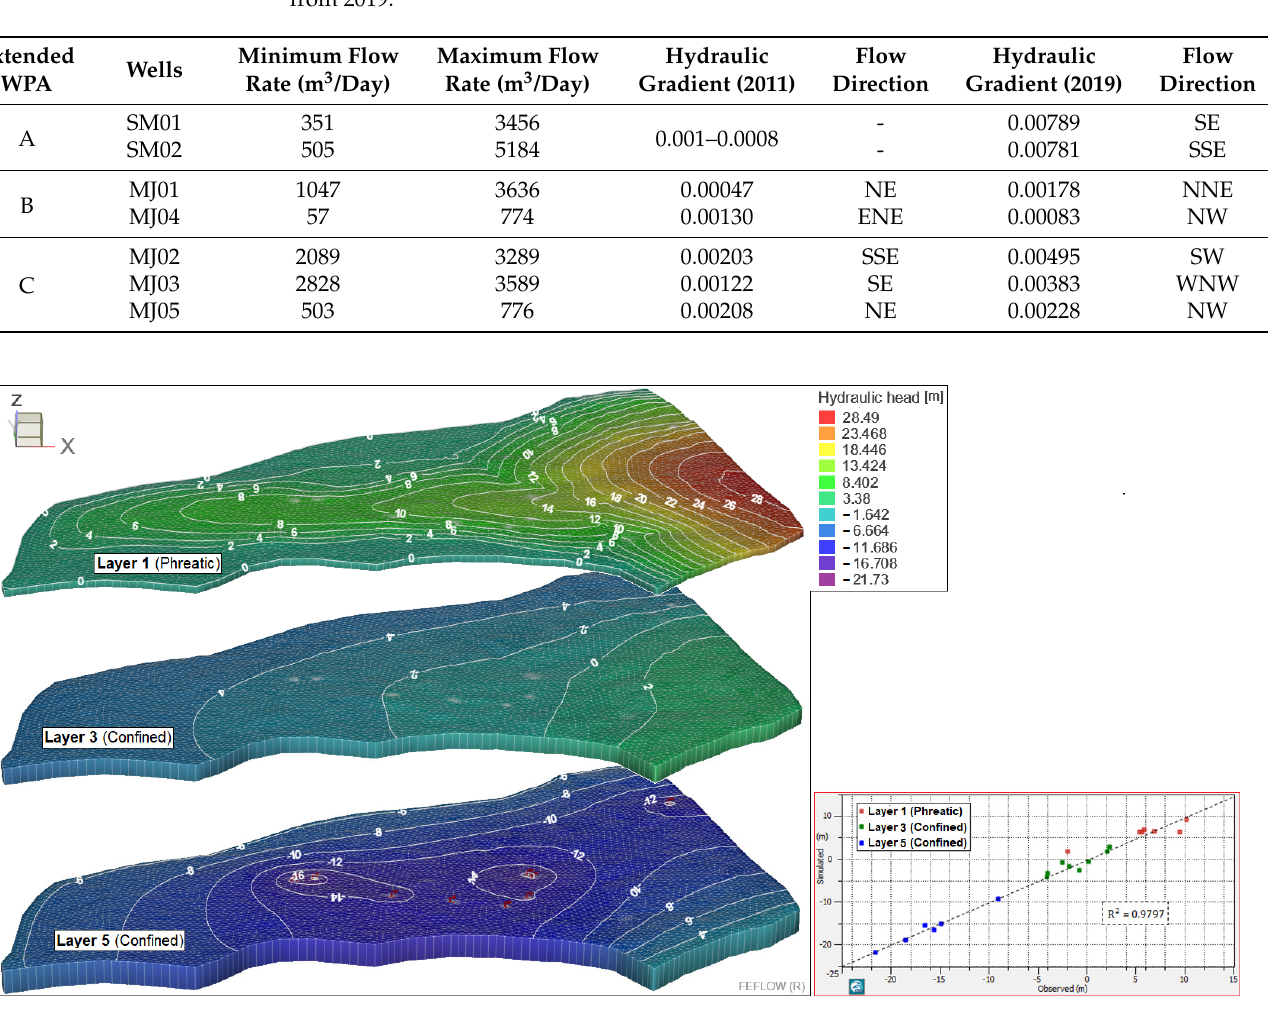
Table 3. Minimum and maximum flowrates for the wells and comparison between the hydraulic gradients and groundwater flow direction, used for delimitation of the actual WPAs (2011), and data from 2020. Extended WPA